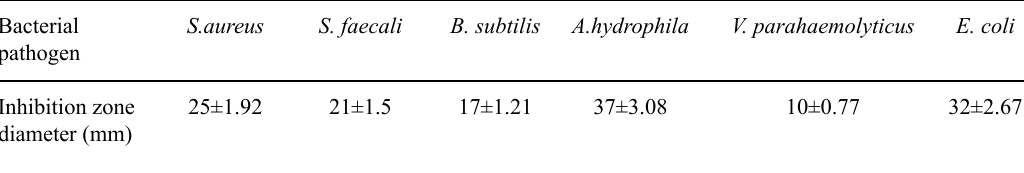
table 2. Antifungal activity of Ag NPs (expressed as inhibition % of fungal growth)